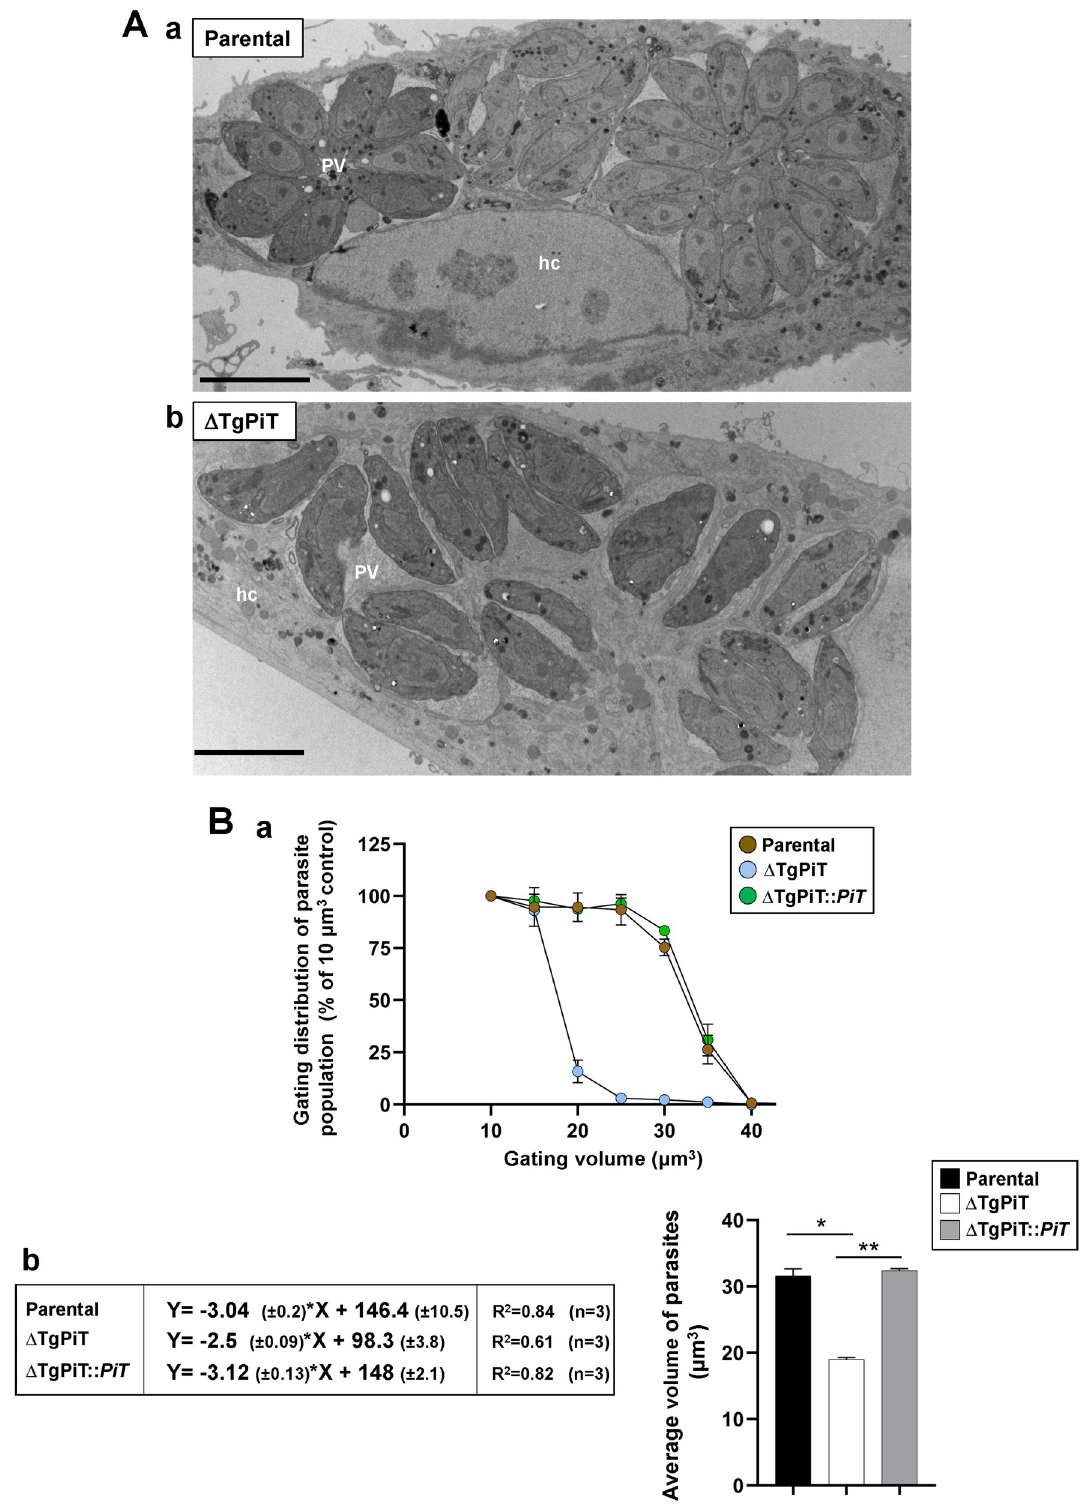
Fig 7. Cell volume of Δ TgPiT parasites. A. EM of HFF infected for 24 h with parental or Δ TgPiT parasites. Comparison between parental (panel a) and Δ TgPiT (panel b) parasites for PV size and parasite global morphology, showing abnormally thinner knockout parasites. Bars, 10 μ m. B. Cell volume measurement of parental, Δ TgPiT and Δ TgPiT:: PiT parasites using a Coulter counter. Panel a: